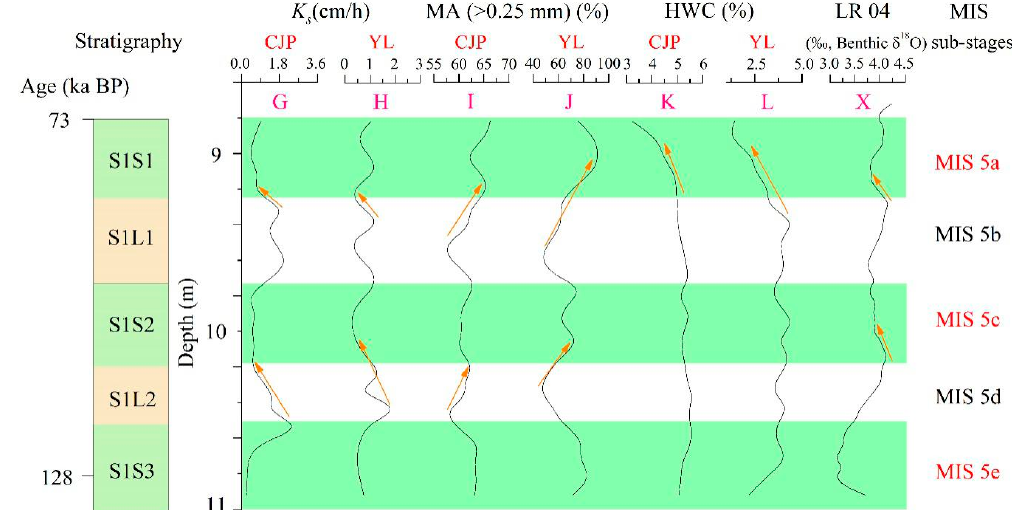
Figure 4. Soil hydraulic parameters of S1 profile as compared with the LR04 curve (X) [36]. The orange arrows indicate the warming trend recorded by the selected parameters and marine records. In this